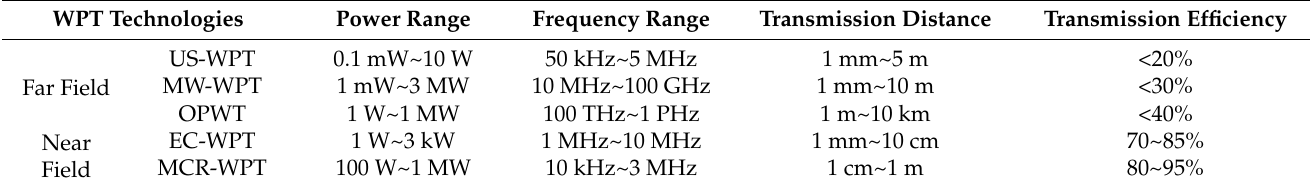
Figure 2. The performance of different types of wireless power transfer technologies in terms of power, frequency and distance. Table 1. Ability Comparison of different WPT technologies.